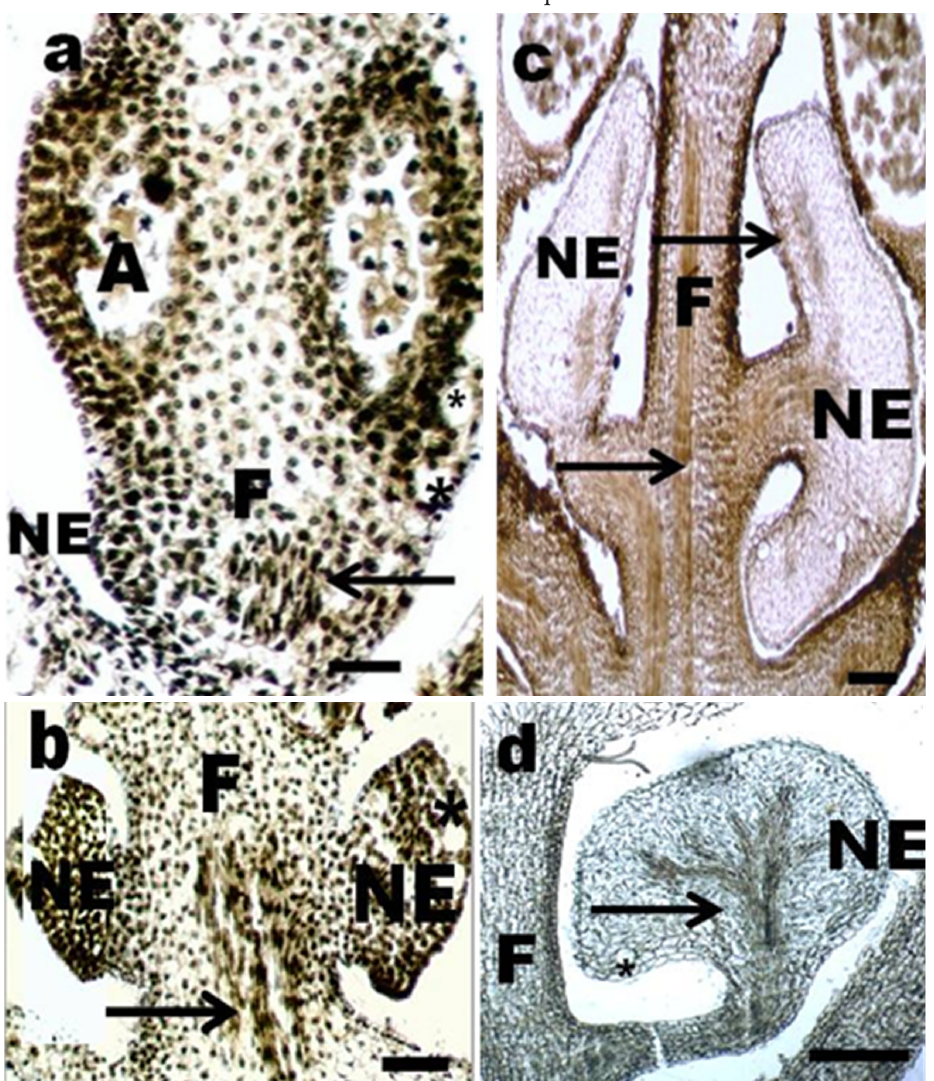
Fig. 5. a-d. Development of a nectarium from young to mature, showing gradual changes. a, b. Stained with hema- toksilen, Bar 100 μm ; c. Stained with Sudan Black B, Bar 100 μm ; d. Stained with Coomassie brilliant blue. An extensive networks of veins in the nectarium are remarkable, Bar 100 μm . A-Anther; F-Filament; Vascular bundles (→); NE-Nectarium, Idioblast cell